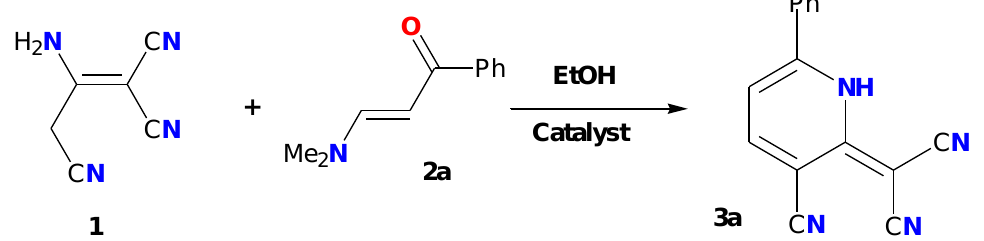
Figure 5. XRD of chitosan ( A ), La 2 O 3 nanoparticles ( B ), and 15 wt% chitosan-La 2 O 3 ( C ). 2.2. CS/La 2 O 3 Nanocomposite Film as Basic Catalyst in Synthesis of Pyridine Derivatives The reaction between malononitrile dimer 1 with enaminone 2a in absolute ethanol was conducted in presence of the CS/La 2 O 3 nanocomposite in order to estimate the opti- mized conditions and the proper catalyst loading (Scheme 1).